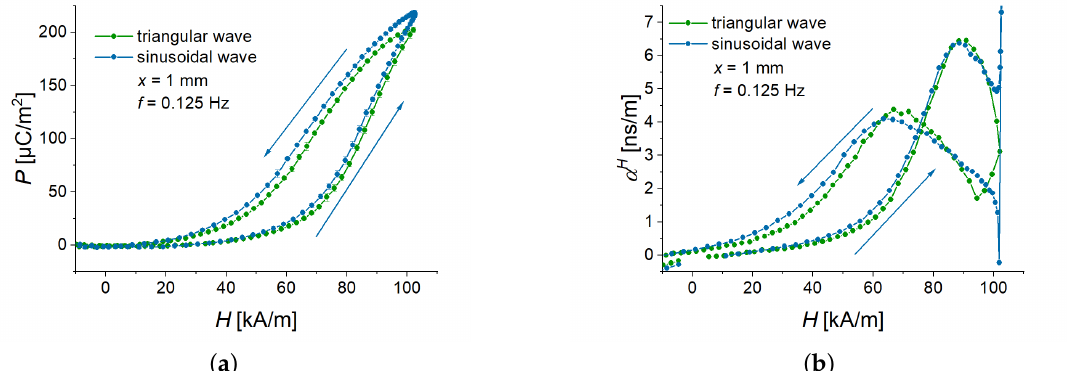
Figure 12. One average pulse of magnetic field and time dependence of the polarization response for symmetric triangle-wave ( a ) and sine-wave ( c ) magnetic field. FFT of magnetic field and electric polarization for symmetric triangular ( b ) and sinusoidal ( d ) waveforms of magnetic field excitation. The amplitudes of the FFT spectra are normalized to their maximum values.